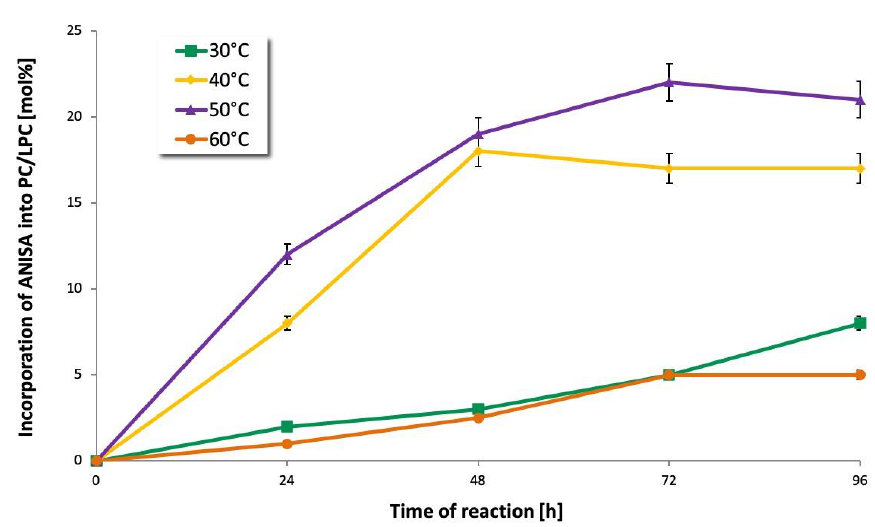
Figure 4. E ff ect of di ff erent temperatures on the incorporation of ANISA into egg-yolk PC in the Figure 4. Effect of different temperatures on the incorporation of ANISA into egg-yolk PC in the acidolysis reaction (reaction conditions: 1:15 PC / ANISA molar ratio, solvent: toluene:chloroform acidolysis reaction (reaction conditions: 1:15 PC/ANISA molar ratio, solvent: toluene:chloroform (9:1 (9:1 v / v ) 2 mL, enzyme load 30% ( w / w ) Novozym 435). Vertical bars represent SD, n = v/v) 2 mL, enzyme load 30% (w/w) Novozym 435). Vertical bars represent SD, n = 3.